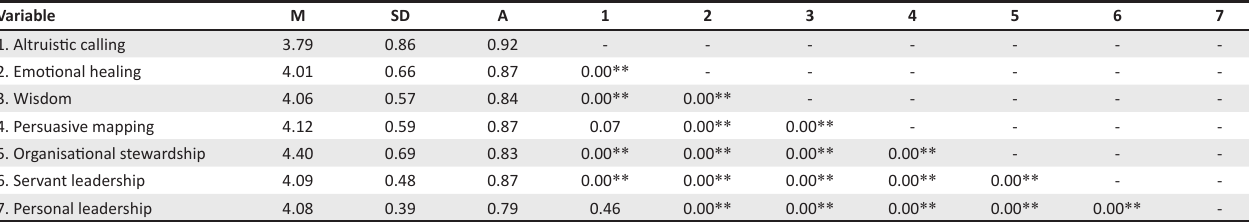
TABLE 3: Means, standard deviations, alpha and correlations.